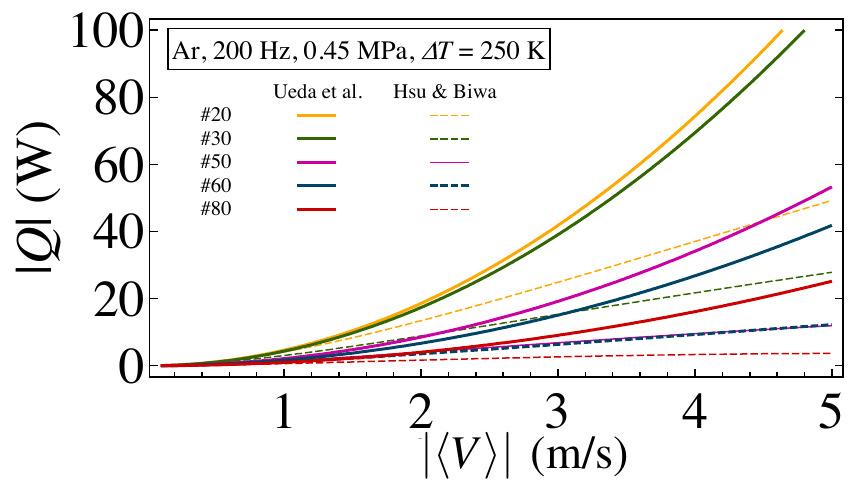
Q given, respectively, by the effective radius | |